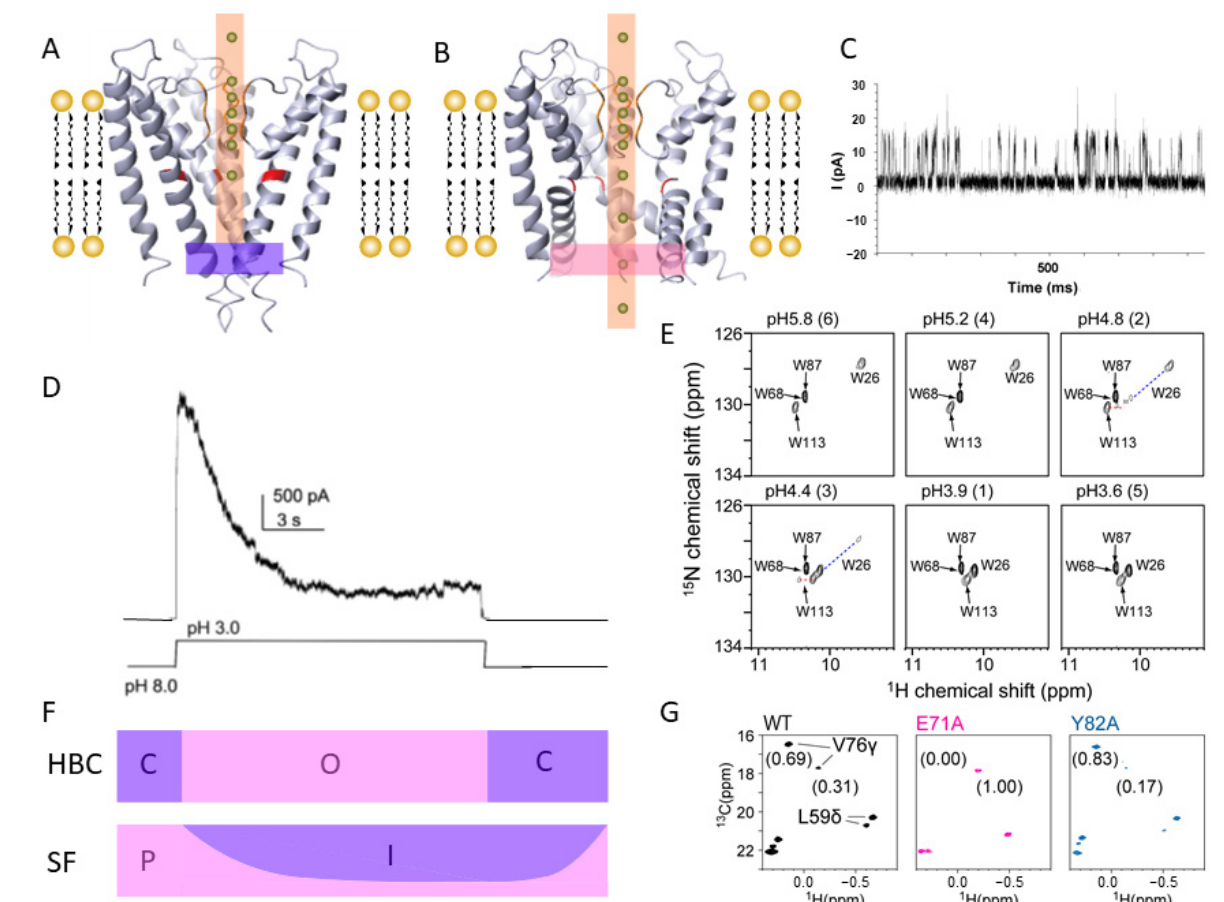
Figure 1. Functional dynamics of an ion channel. ( A ) Crystal structure of KcsA in the closed conformation at neutral pH (PDB ID: 1BL8). ( B ) Crystal structure of pore domain of MthK in the open conformation (PDB ID: 1LNQ). ( C ) Single-channel recording of KcsA in acidic condition [14]. ( D ) A macroscopic current of KcsA after pH jump. ( E ) Close-up view of the Trp indole region of the 1 H– 15 N TROSY HSQC spectra of H α -partially protonated/ 2 H/ 15 N-labeled Δ 125–160 KcsA. The resonances from Trp-68 and Trp-87 overlap with each other. Assignments were established by site-specific mutagenesis. The dashed lines connect corresponding signals. ( F ) The conformational state of HBC and SF in the corresponding condition is shown in panel ( D ). ( G ) Methyl-TROSY spectra of WT (Left), the E71A (Middle), and Y82A (Right) mutants at pH 3.2 and 25 °C. The numbers in parentheses are the relative intensities of the two signals of V76 γ . The figure was reproduced from [14,16,17] with permission.